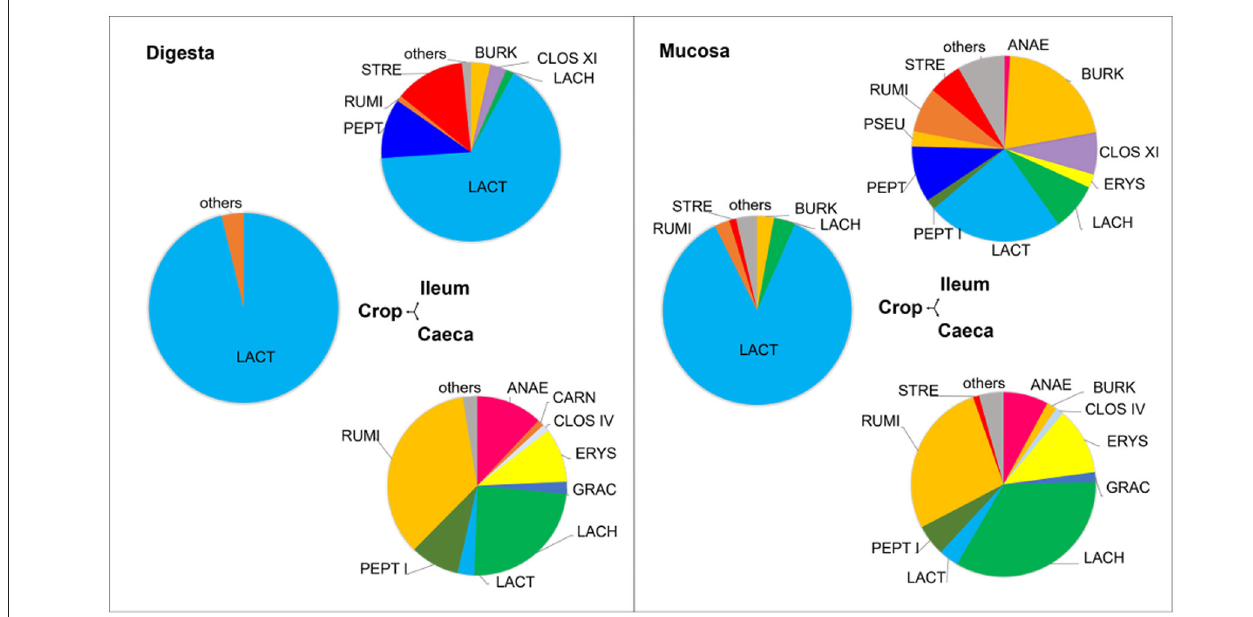
FIGURE 2 | Family distribution of digesta and mucosa samples in the crop, ileum, and caeca. OTUs present in 281 samples were taxonomically assigned to a family and families present in abundances higher than 1% plotted. Abbreviations in the graph represent each family: ANAE, Anaeroplasmataceae; BURK, Burkholderiaceae; CARN, Carnobacteriaceae; CLOS IV, Clostridiales incertae sedis IV; CLOS XI, Clostridiales incertae sedis XI; ERYS, Erysipelotrichaceae; GRAC, Gracilibacteriaceae; LACH, Lachnospiraceae; LACT, Lactobacillus; PEPT I, Peptococcaceae I; PEPT, Peptostreptococcacaea; PSEU, Pseudomonadaceae; RUMI, Ruminococcaceae; STRE, Streptococcaceae, ( Table S6